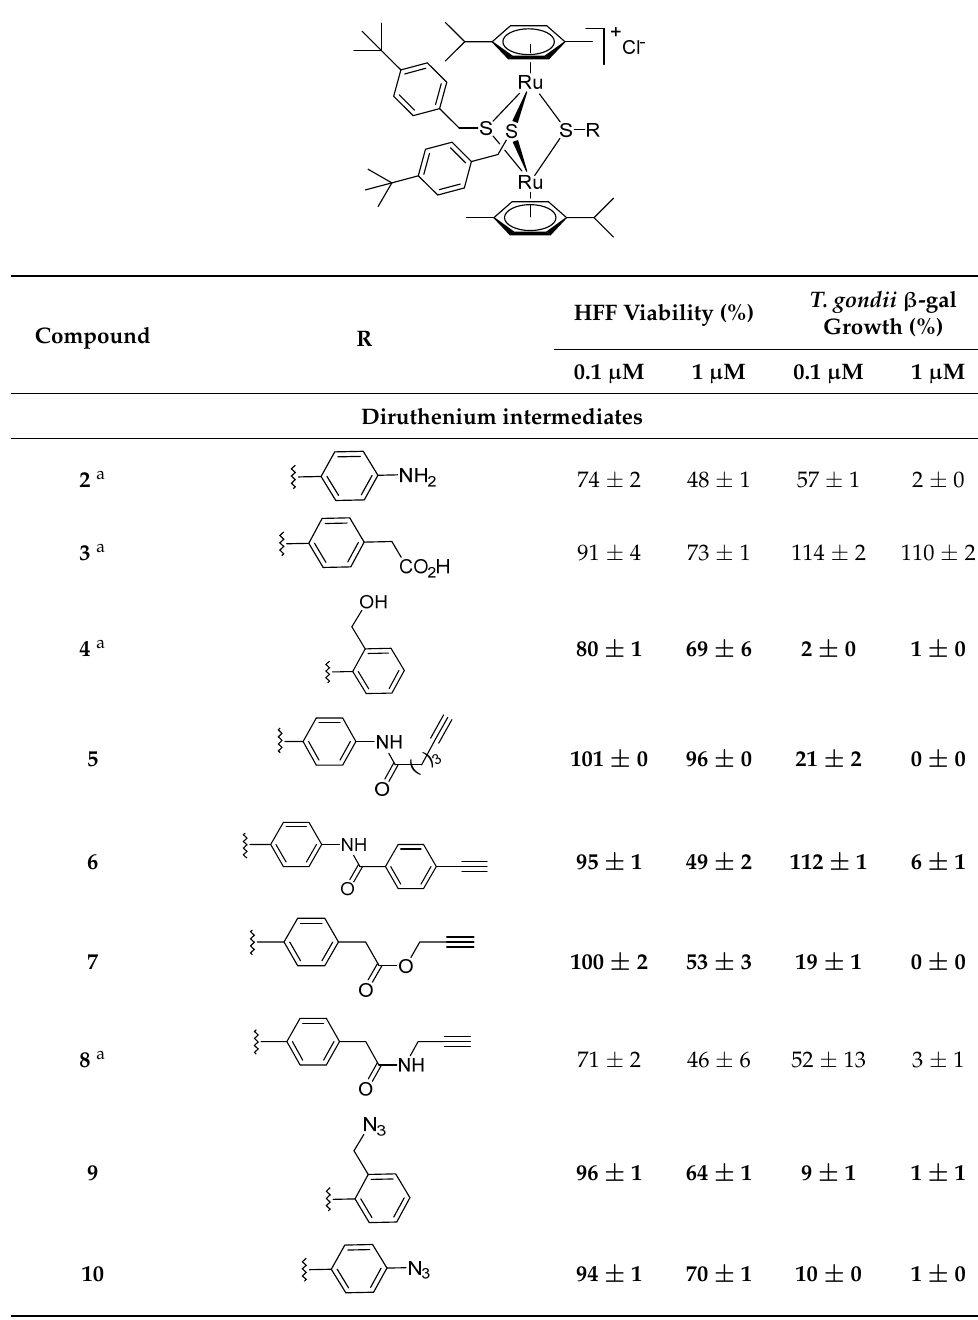
of 0.1 and 1 µ M. In a second screening, the selected compounds (which at 1 µ M inhibited T. gondii - β -gal proliferation by at least 90% and impaired the HFF viability not more than 50%) were submitted to dose-response studies to determine the IC 50 values, while cyto- toxicity in HFF was assessed at 2.5 µ M (the results are summarized in Table 2). The same screening strategy was applied in previous studies [111]. Pyrimethamine (IC 50 = 0.326 µ M) while cytotoxicity in HFF was assessed at 2.5 μ M (the results are summarized in Table 2). was used as reference compound as shown earlier [93]. The same screening strategy was applied in previous studies [111]. Pyrimethamine (IC 50 while cytotoxicity in HFF was assessed at 2.5 μ M (the results are summarized in Table 2). while cytotoxicity in HFF was assessed at 2.5 μ M (the results are summarized in Table 2). = 0.326 μ M) was used as reference compound as shown earlier [93]. The same screening strategy was applied in previous studies [111]. Pyrimethamine (IC 50 The same screening strategy was applied in previous studies [111]. Pyrimethamine (IC 50 Table 1. Primary cytotoxicity/efficacy screening of all compounds in non-infected HFF cultures and = 0.326 μ M) was used as reference compound as shown earlier [93]. = 0.326 μ M) was used as reference compound as shown earlier [93]. T. gondii β -gal tachyzoites cultured in HFF. Tests were performed in triplicate. The 20 compounds Table 1. Primary cytotoxicity/efficacy screening of all compounds in non ‐ infected HFF cultures and selected for the dose-response study against T. gondii β -gal and the assessment of the toxicity against T. gondii β‐ gal tachyzoites cultured in HFF. Tests were performed in triplicate. The 20 compounds Table 1. Primary cytotoxicity/efficacy screening of all compounds in non ‐ infected HFF cultures and Table 1. Primary cytotoxicity/efficacy screening of all compounds in non ‐ infected HFF cultures and Table 1. Primary cytotoxicity/efficacy screening of all compounds in non ‐ infected HFF cultures and Table 1. Primary cytotoxicity/efficacy screening of all compounds in non ‐ infected HFF cultures and Table 1. Primary cytotoxicity/efficacy screening of all compounds in non ‐ infected HFF cultures and Table 1. Primary cytotoxicity/efficacy screening of all compounds in non ‐ infected HFF cultures and Table 1. Primary cytotoxicity/efficacy screening of all compounds in non ‐ infected HFF cultures and Table 1. Primary cytotoxicity/efficacy screening of all compounds in non ‐ infected HFF cultures and Table 1. Primary cytotoxicity/efficacy screening of all compounds in non ‐ infected HFF cultures and HFF are highlighted in bold. selected for the dose ‐ response study against T. gondii β‐ gal and the assessment of the toxicity against T. gondii β‐ gal tachyzoites cultured in HFF. Tests were performed in triplicate. The 20 compounds T. gondii β‐ gal tachyzoites cultured in HFF. Tests were performed in triplicate. The 20 compounds T. gondii β‐ gal tachyzoites cultured in HFF. Tests were performed in triplicate. The 20 compounds T. gondii β‐ gal tachyzoites cultured in HFF. Tests were performed in triplicate. The 20 compounds T. gondii β‐ gal tachyzoites cultured in HFF. Tests were performed in triplicate. The 20 compounds T. gondii β‐ gal tachyzoites cultured in HFF. Tests were performed in triplicate. The 20 compounds T. gondii β‐ gal tachyzoites cultured in HFF. Tests were performed in triplicate. The 20 compounds T. gondii β‐ gal tachyzoites cultured in HFF. Tests were performed in triplicate. The 20 compounds T. gondii β‐ gal tachyzoites cultured in HFF. Tests were performed in triplicate. The 20 compounds HFF are highlighted in bold. selected for the dose ‐ response study against T. gondii β‐ gal and the assessment of the toxicity against selected for the dose ‐ response study against T. gondii β‐ gal and the assessment of the toxicity against selected for the dose ‐ response study against T. gondii β‐ gal and the assessment of the toxicity against selected for the dose ‐ response study against T. gondii β‐ gal and the assessment of the toxicity against selected for the dose ‐ response study against T. gondii β‐ gal and the assessment of the toxicity against selected for the dose ‐ response study against T. gondii β‐ gal and the assessment of the toxicity against selected for the dose ‐ response study against T. gondii β‐ gal and the assessment of the toxicity against selected for the dose ‐ response study against T. gondii β‐ gal and the assessment of the toxicity against selected for the dose ‐ response study against T. gondii β‐ gal and the assessment of the toxicity against HFF are highlighted in HFF are highlighted in bold. HFF are highlighted in bold. HFF are highlighted in bold. HFF are highlighted in bold. HFF are highlighted in bold. HFF are highlighted in bold. HFF are highlighted in bold. HFF are highlighted in bold.